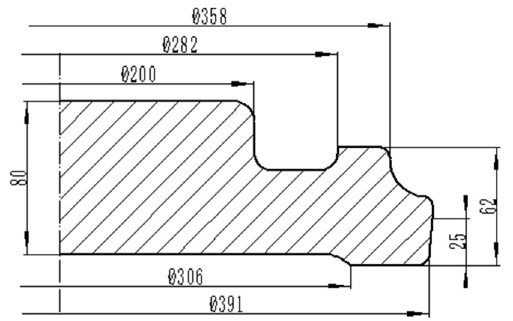
Figure 14. Plate forging.